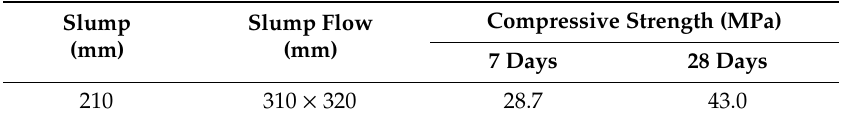
Table 12. Fresh and hardened properties of marble-based geopolymer mortar for making Jersey barriers at a ready-mixed